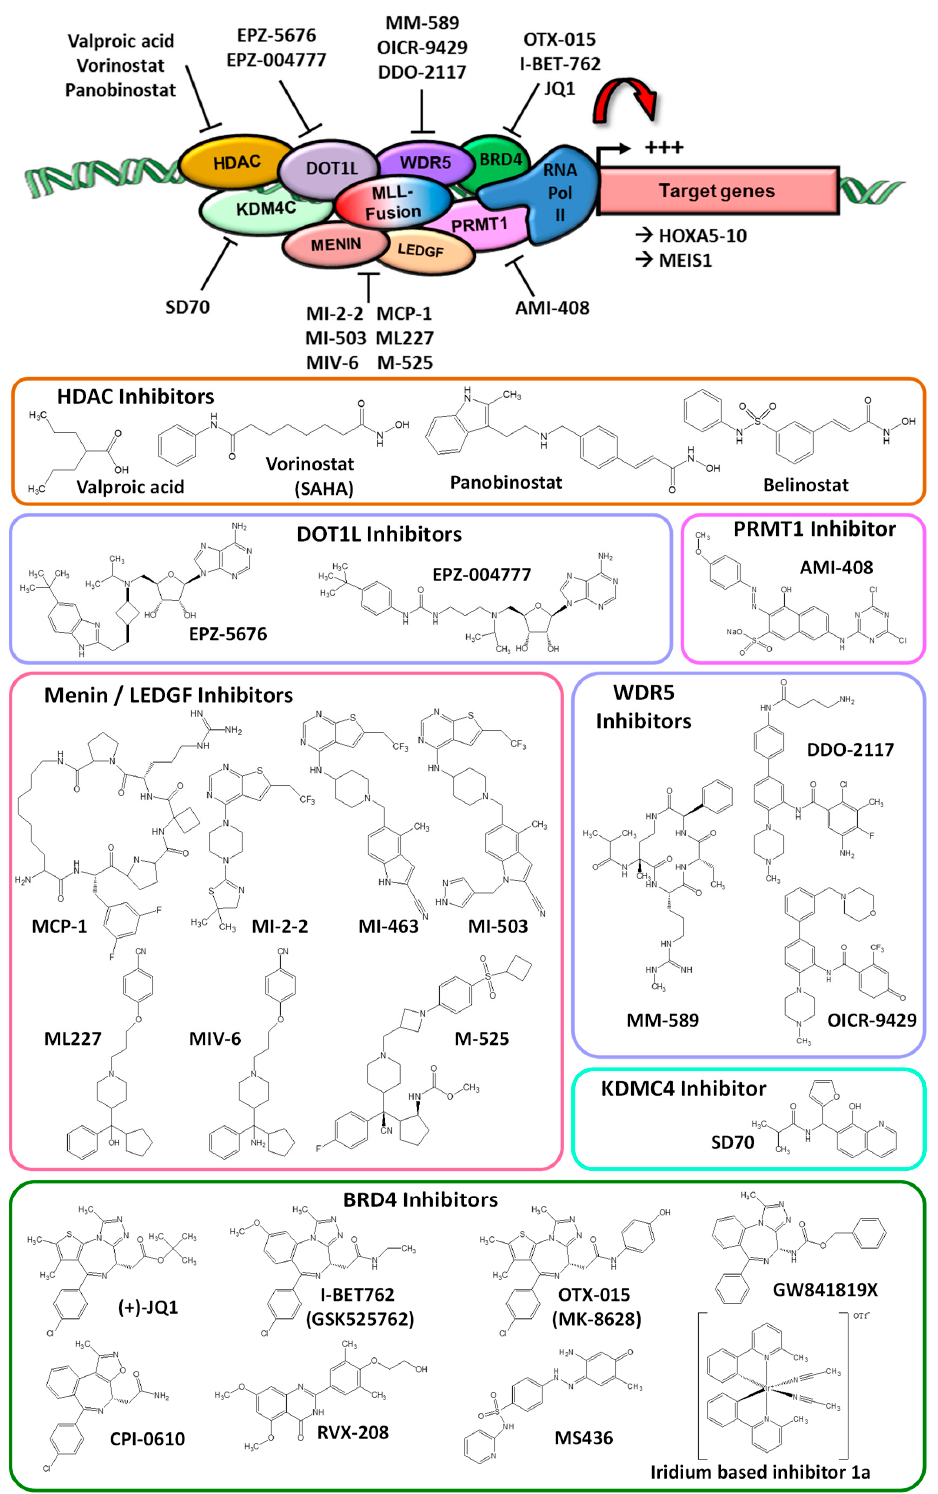
Figure 1. Targeting the MLL complex at the epigenetic level controls the expression of the HOXA cluster of transcription factors. Top of the figure: scheme of proteins associated with the fused-MLL complex highlighting the ones targeted by the different inhibitors indicated below.